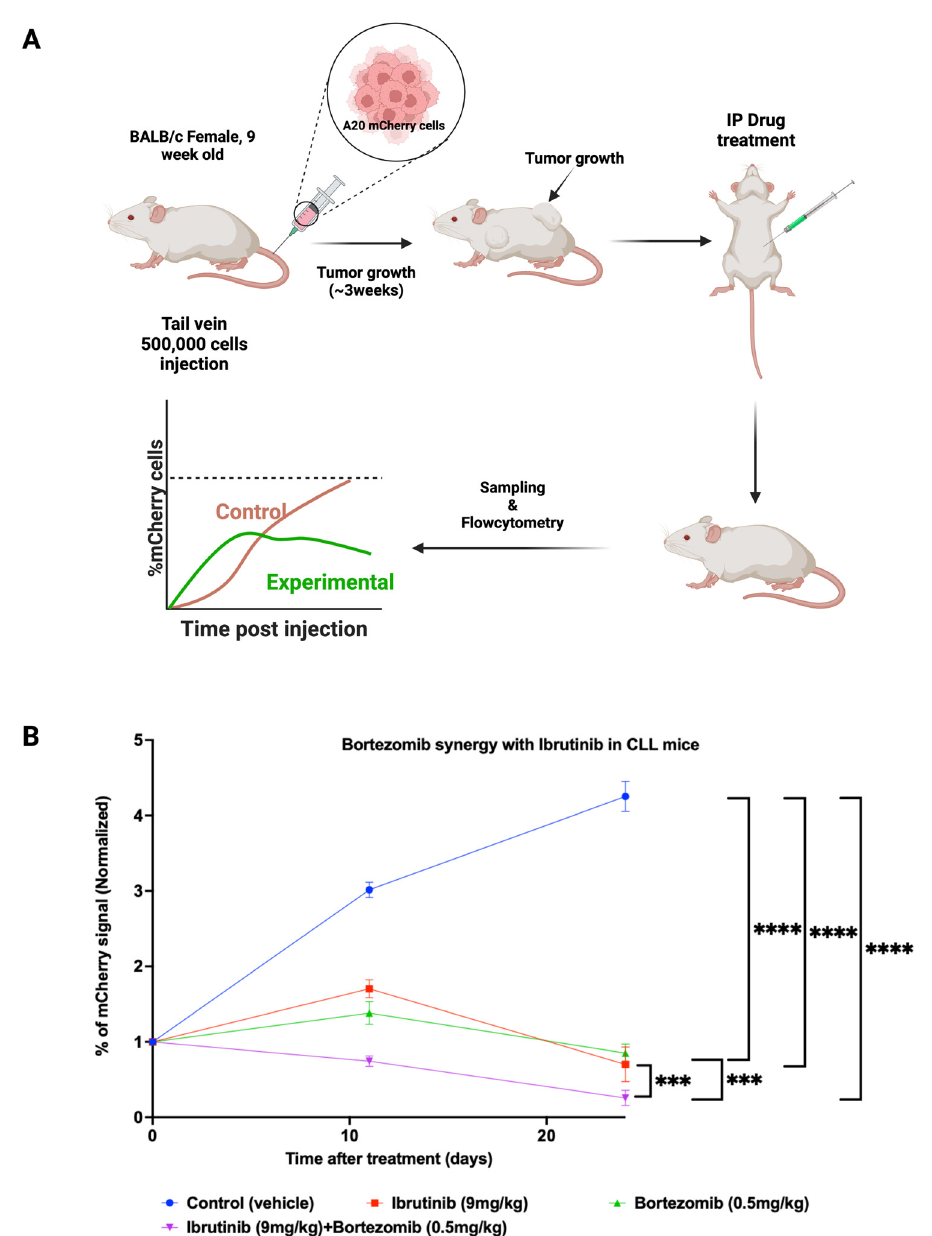
Figure 2. In vivo effects of ibrutinib and bortezomib on A20 leukemia. ( A ). Representative scheme of the animal experiment where 0.5 × 10 6 A20 labeled Luc-mCherry cells were implanted by the tail vein injection. Three weeks later, the mice were treated with (1) vesicle, (2) Ibrutinib 9 mg/kg, (3) Bortezomib 0.5 mg/kg twice a week, and (4) combined Ibrutinib with Bortezomib. The influence of the drug treatments was tested by sampling the blood taken from the tail vein at two time points and analyzing it by FACS ( B ). Percentage of mCherry-positive A20 cells in the blood of mice treated for 11 and 24 days; blue curve group treated with vehicle, red curve treated with ibrutinib, yellow curve treated with bortezomib, and green curve treated with ibrutinib and bortezomib together. Each group had n = 4 mice; the error bar represents the standard deviation between the replicates in each group. Statistical analysis was performed using two-way ANOVA. All statistical analyses were performed using Graphpad (v9), level of significance was taken as (*** “ p ” < 0.0002, **** “ p” < 0.0001) as denoted appropriately on the above